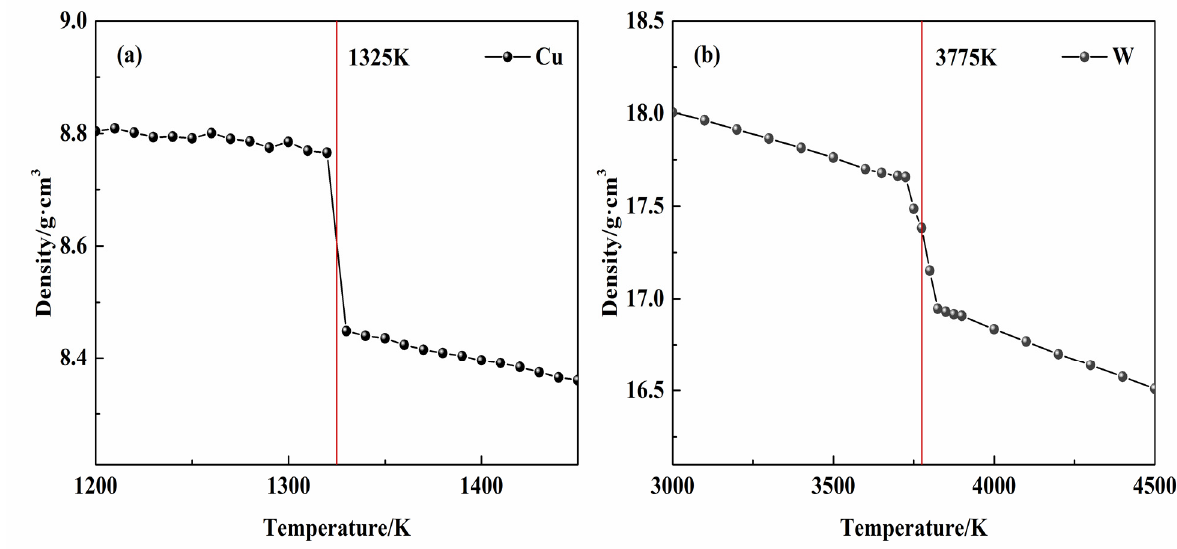
Figure 2. Relationship between W/Cu density and